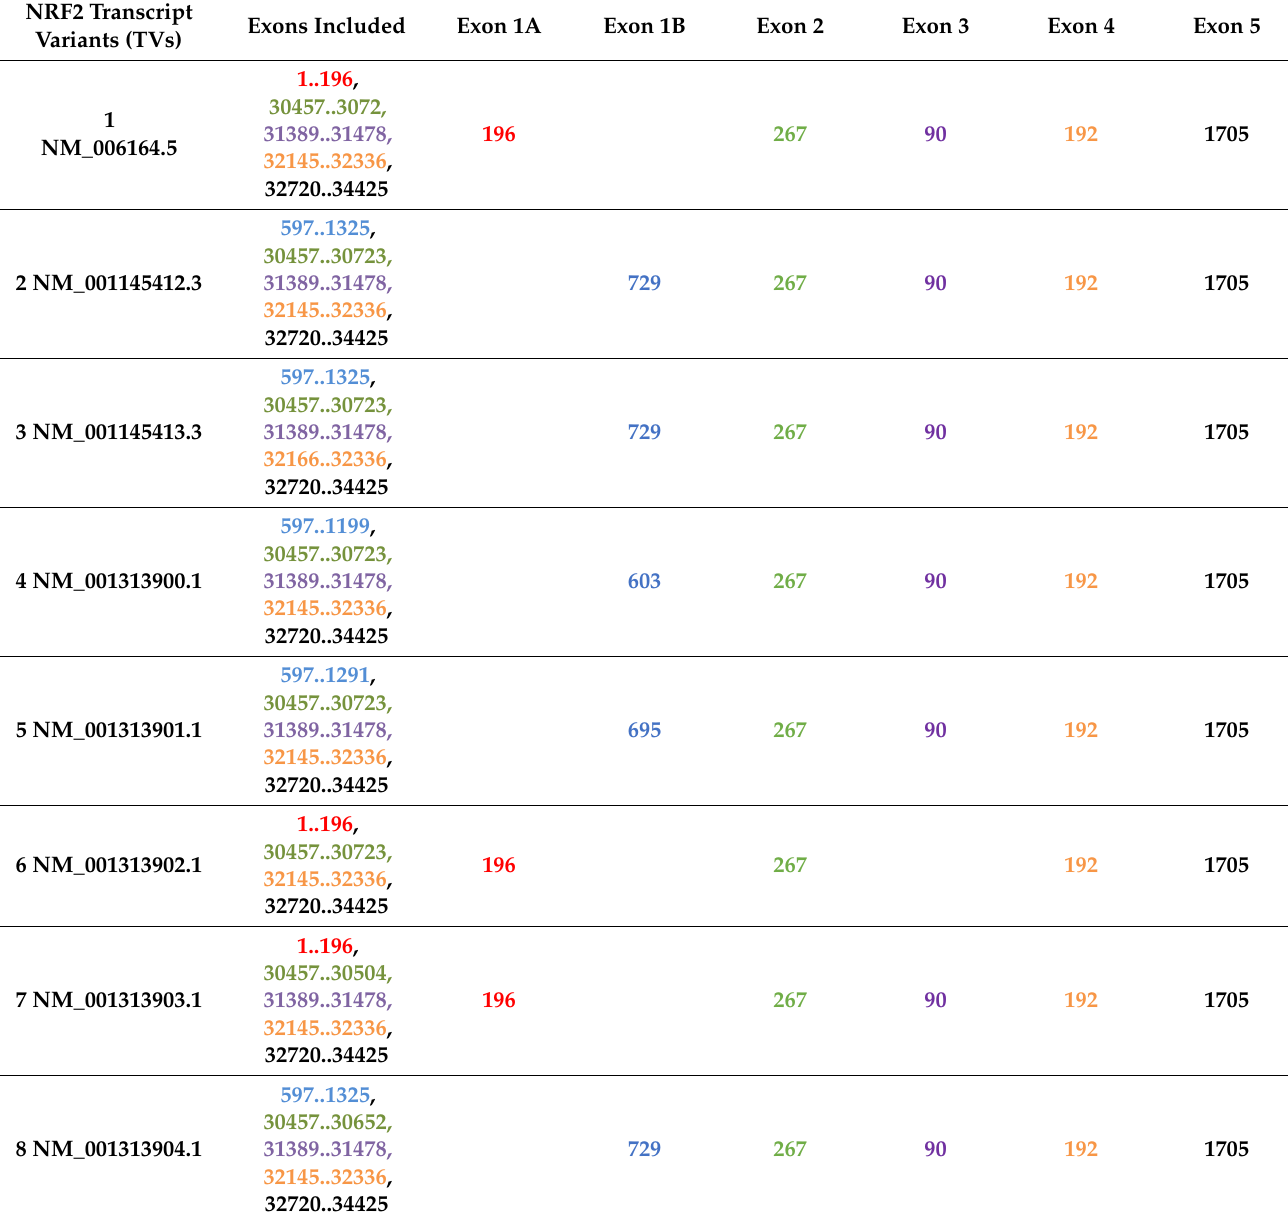
Table 1. Current NRF2 messenger RNAs deposited in the NCBI database